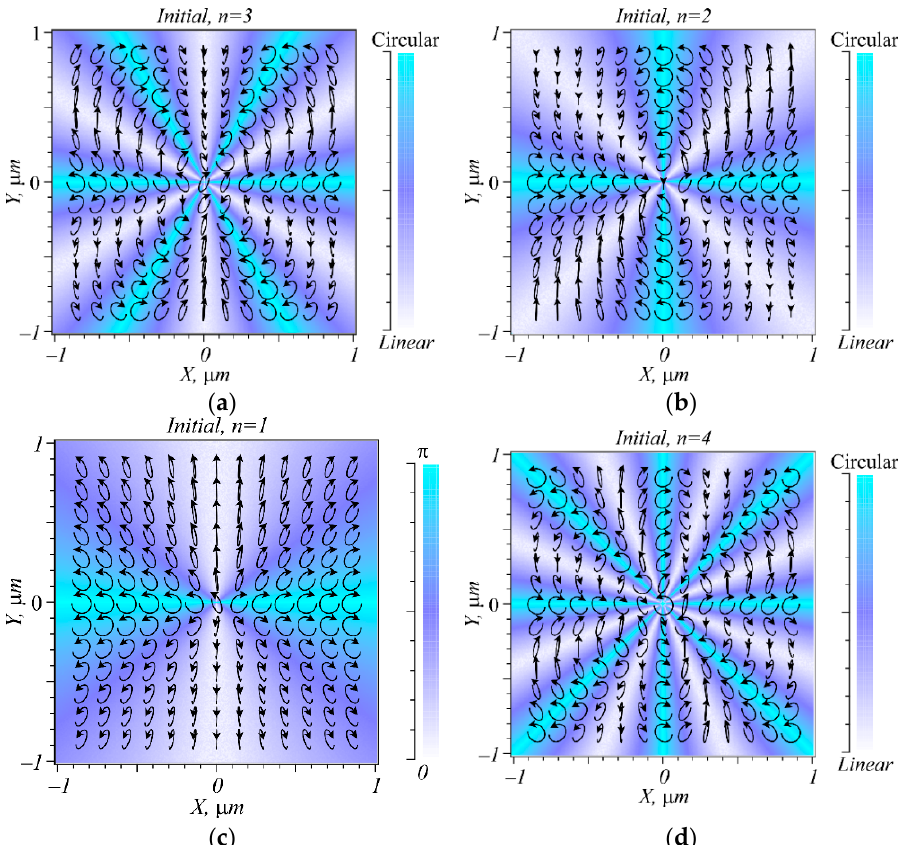
Figure 1. Polarization patterns (shown in half-tones and with arrows) in the source field (1) at α = 1 at different orders n : 3 ( a ), 2 ( b ), 1 ( c ), 4 ( d ). The arrows show the handedness of the E-vector; the origin of the ellipse is determined based on the phase of the field at this point.